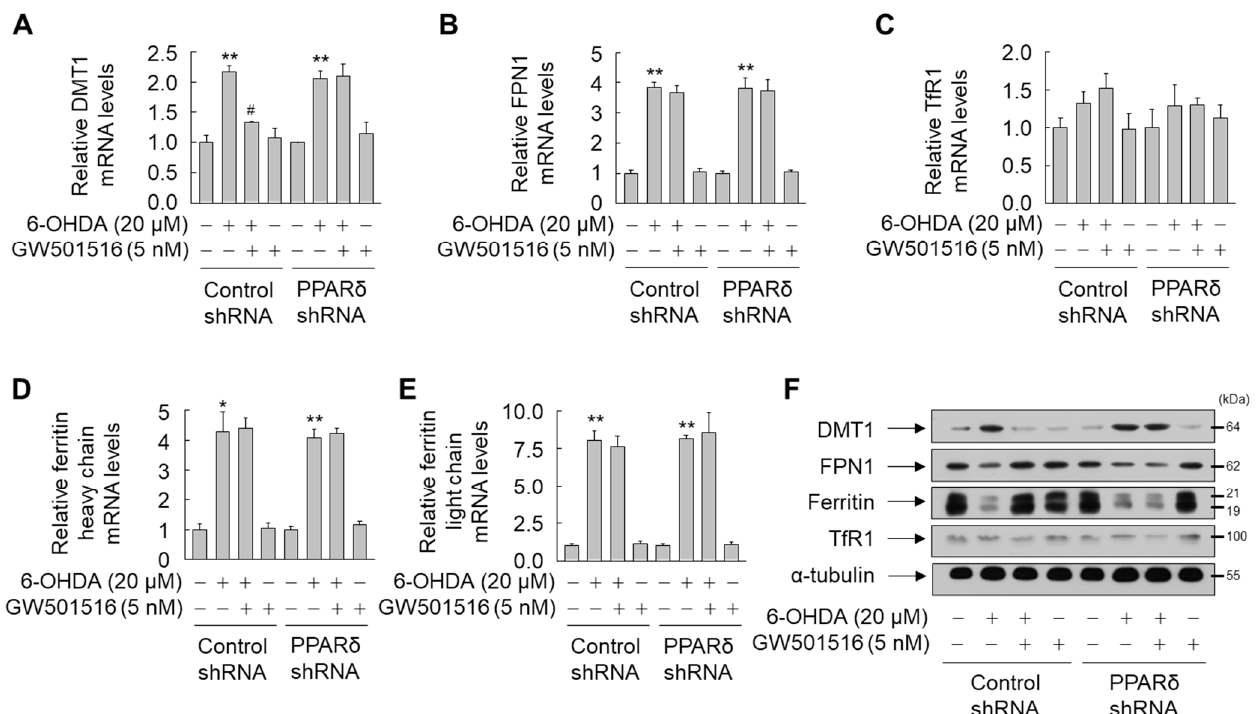
Figure 5. PPAR δ knockdown abrogated the effects of GW501516 on 6-OHDA-triggered protein levels of DMT1, FPN1, and Ferritin, and mRNA expression of DMT1. Cells stably expressing shRNA targeting scrambled sequences or PPAR δ were pretreated with DMSO or GW501516 for 8 h, and subsequently incubated with or without 6-OHDA for 16 h. Total RNA and protein were extracted, and levels of mRNA and protein were analyzed by real-time PCR ( A – E ) and Western blot ( F ). RPS18 and α -tubulin were used as internal controls for real-time PCR and Western blot, respectively. Results are expressed as means of triplicate ± SE ( A – D ). * p < 0.05, ** p < 0.01 relative to untreated group; # p < 0.05 relative to 6-OHDA-treated